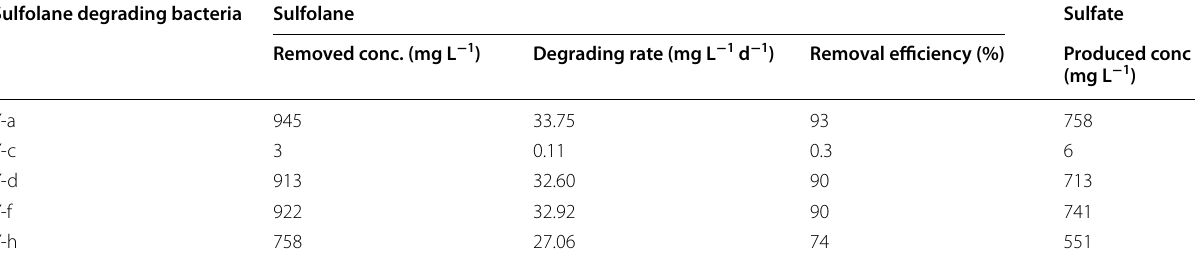
Table 1 Sulfolane biodegradation and sulfate production of 5 sulfolane degrading bacteria as 1000 mg L − 1 sulfolane as the sole carbon source at pH of 7 Sulfolane degrading bacteria